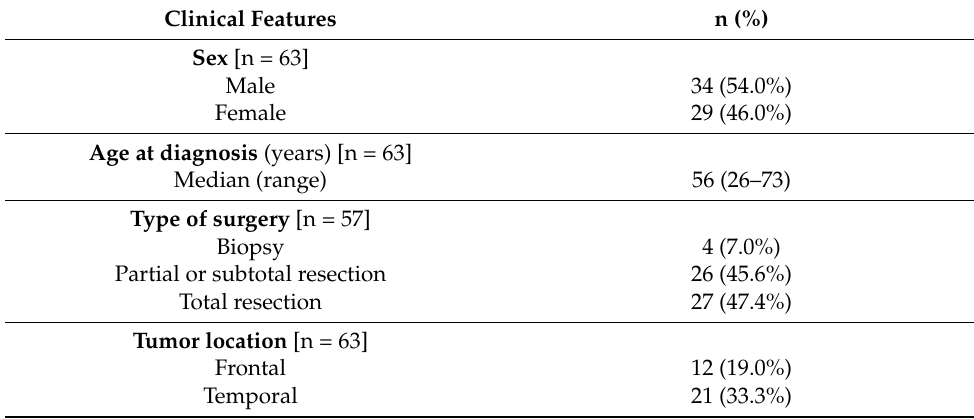
Table 2. Summary of GB patients’ clinical